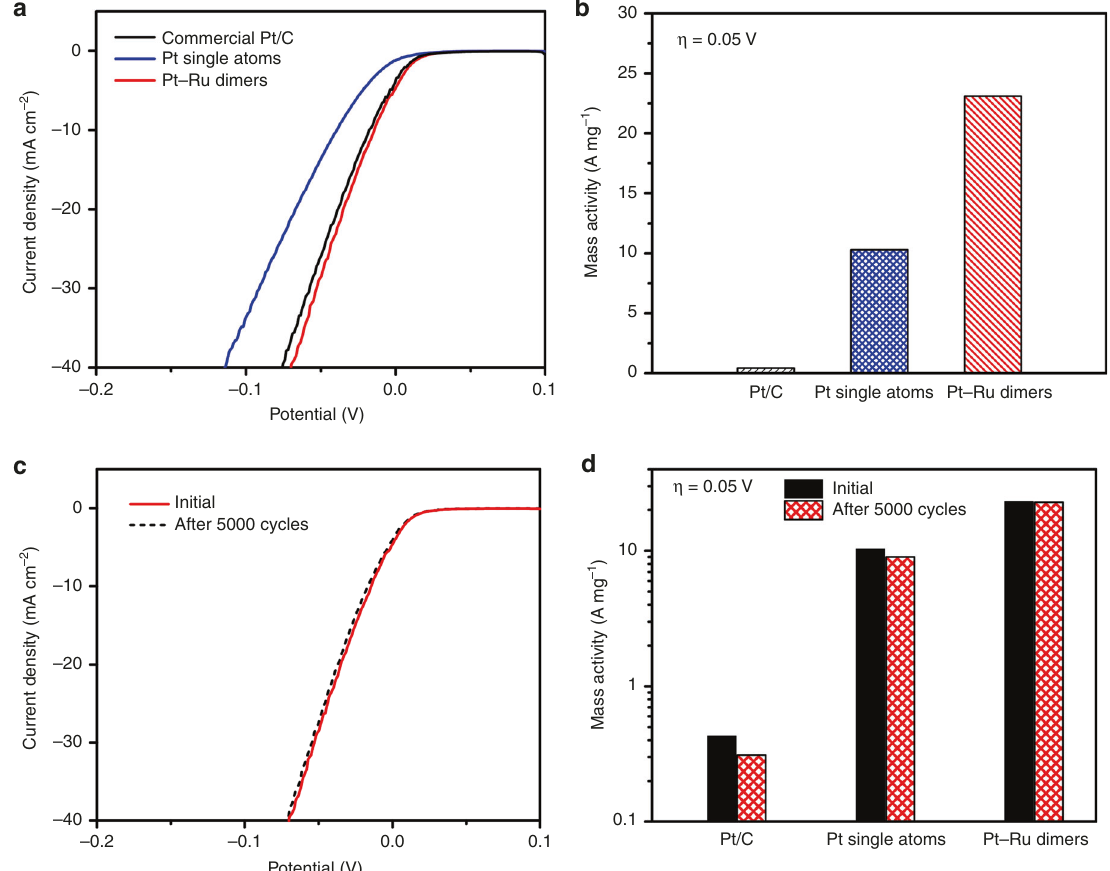
Fig. 4 Electrocatalytic performance of Pt – Ru dimers towards HER. a The HER polarization curves recorded on Pt – Ru dimers, Pt single atoms and Pt/C catalysts. b Normalized mass activity at 0.05 V of Pt – Ru dimers, Pt single atoms and Pt/C catalysts. c Durability measurement of the Pt – Ru dimers catalysts. d Normalized mass activity at 0.05 V of Pt – Ru dimers, Pt single atoms and Pt/C catalysts before and after durability tests. The Pt mass loadings for Pt/C, Pt single atoms, and Pt – Ru dimers are 61.2, 1.34 and 1.24 μ g cm − 2 ,